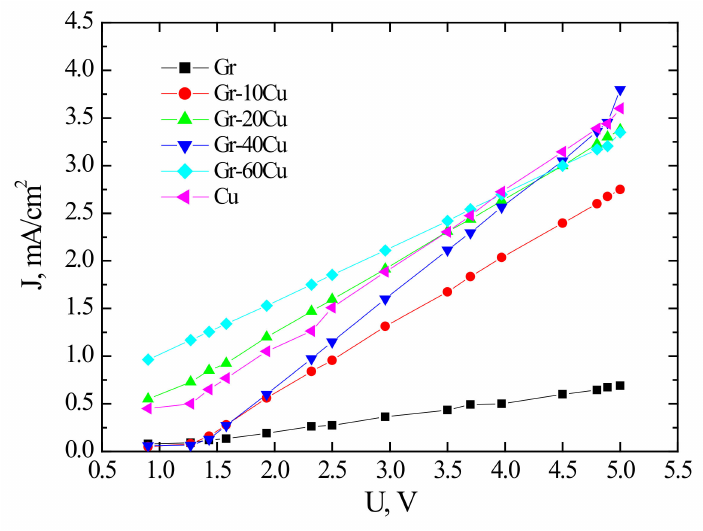
Figure 5. Photocurrent density versus voltage when films were deposited by plasma spraying.